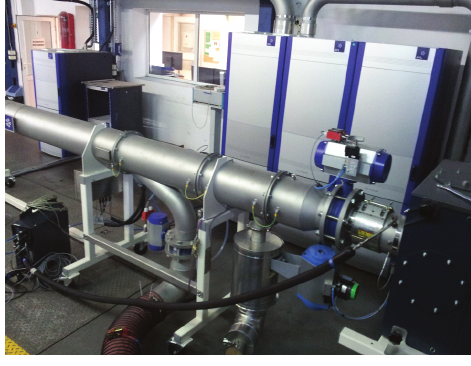
Fig. 2. A set of AMA i60 measuring devices